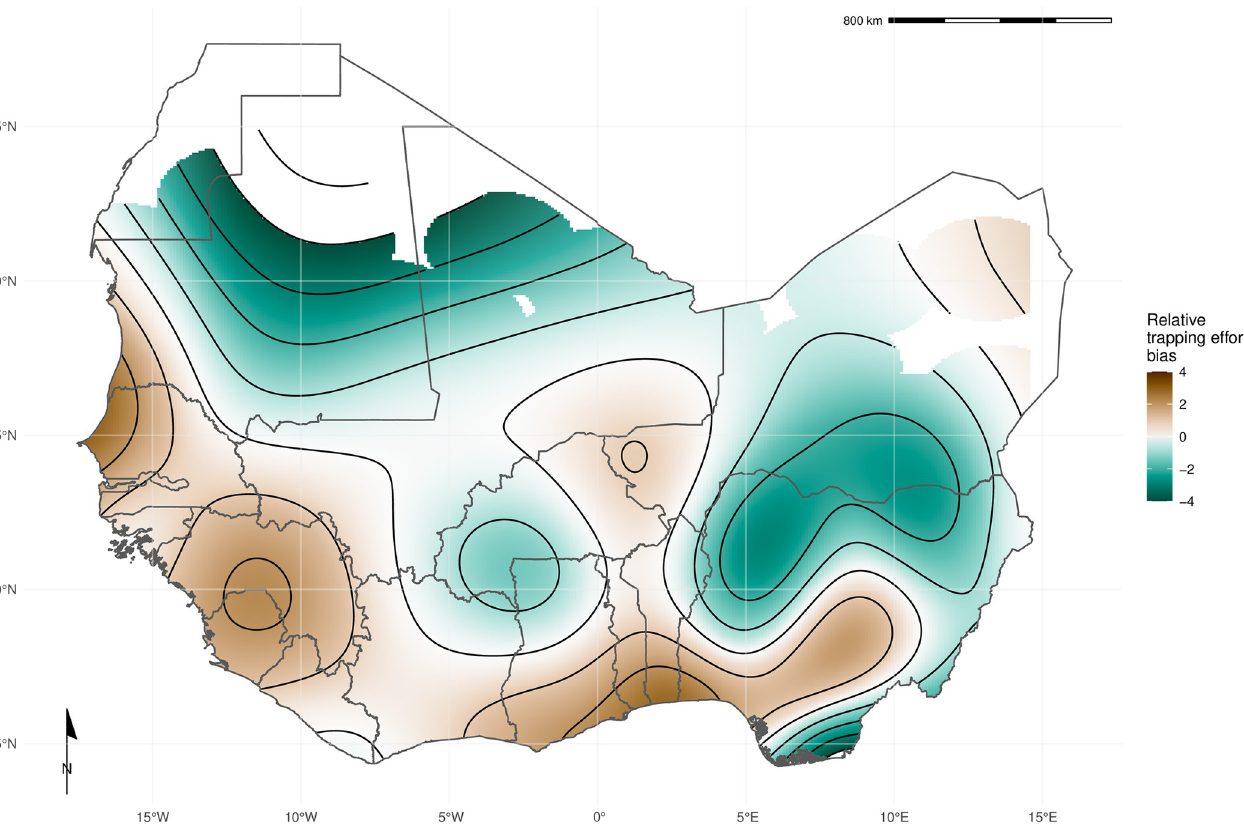
Fig 2. Relative trapping effort bias across West Africa. Modelled relative trapping effort bias adjusted for human population density, proportion urban land cover and area of the administrative region. Brown regions represent areas with a bias towards increased trapping effort (e.g., North West Senegal), Green regions represent areas with a bias towards reduced trapping effort (e.g., Northern Nigeria). Basemap shapefile obtained from GADM 4.0.4 [38].